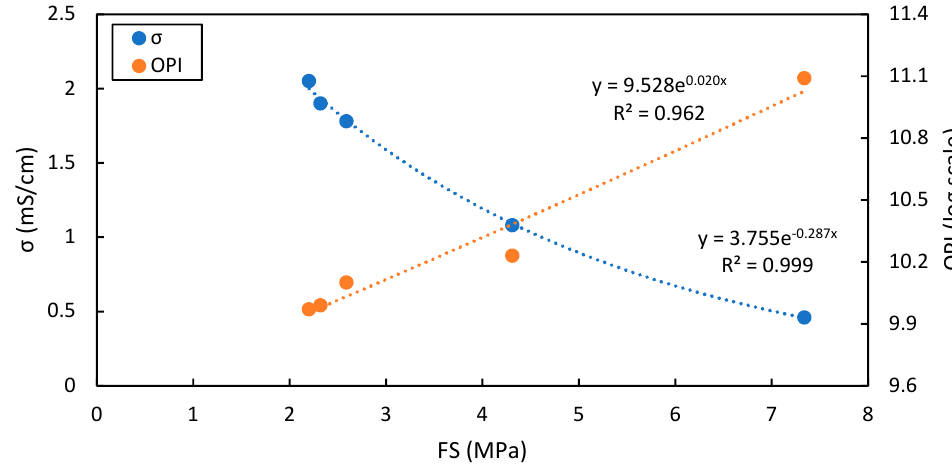
Figure 24. Correlation between the FS and the DI performance ( σ and OPI).